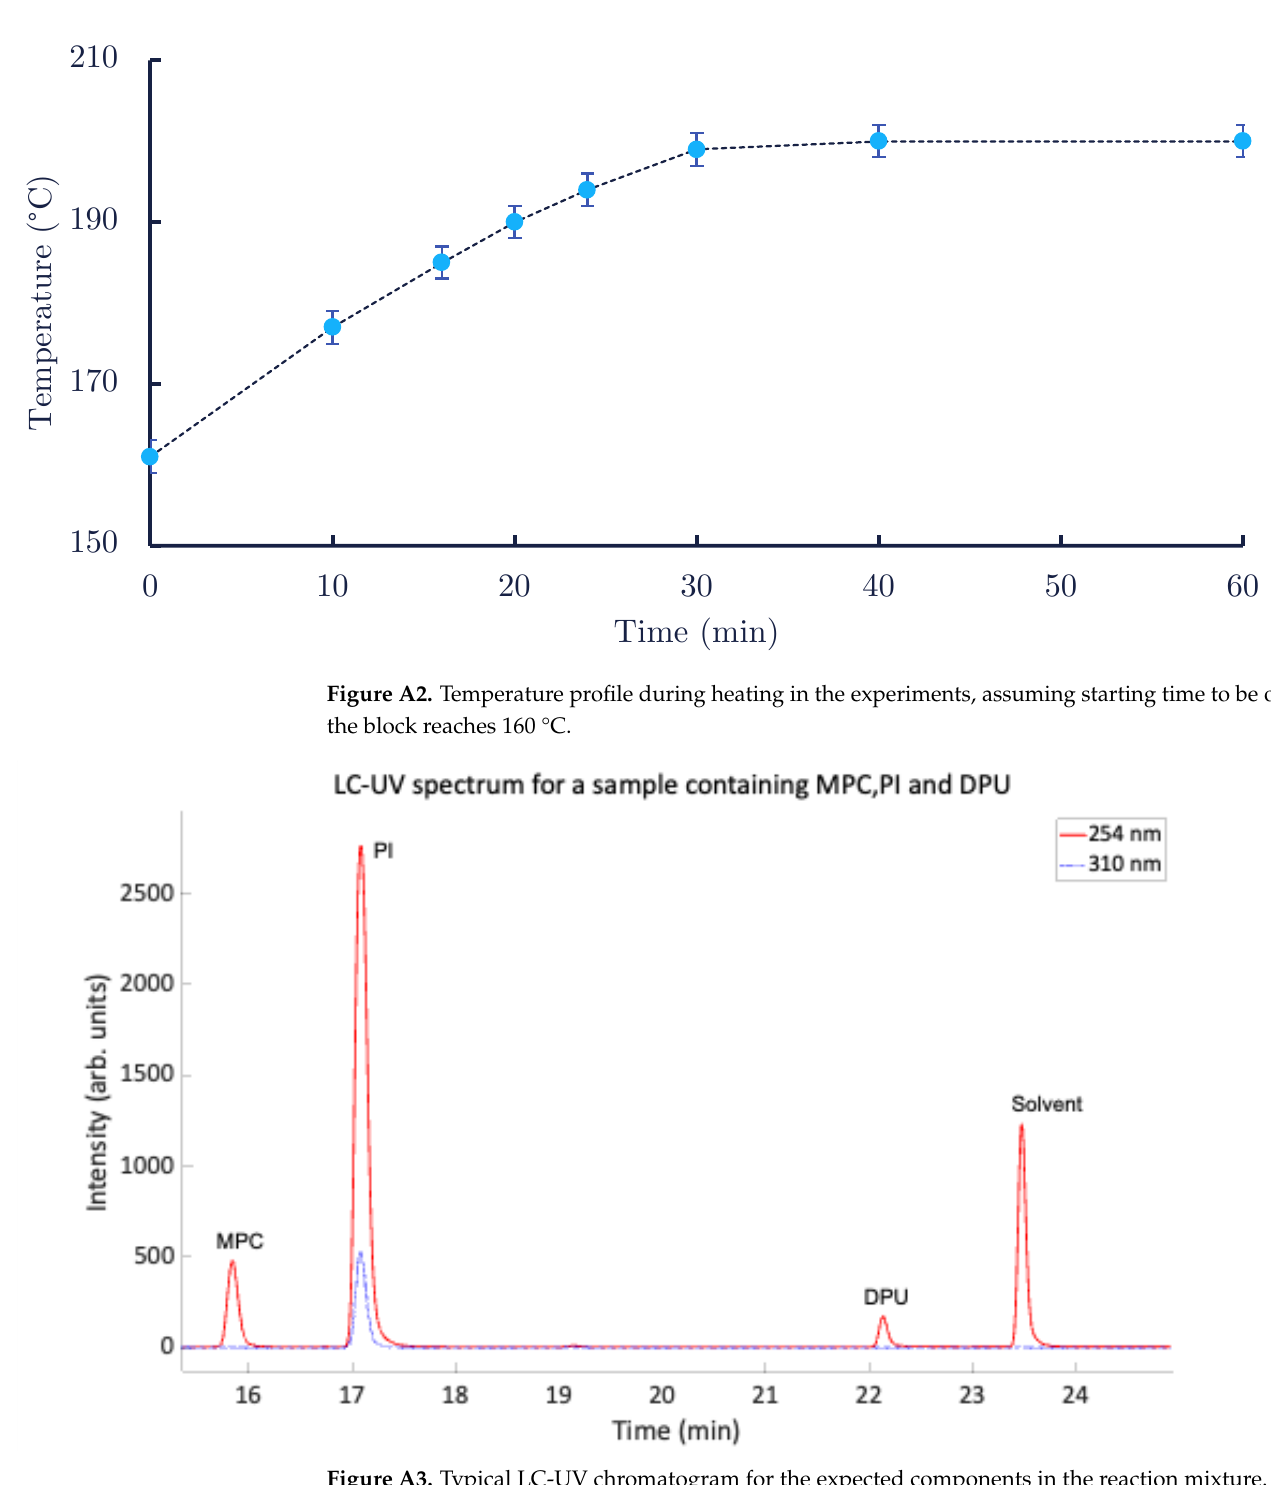
Figure A3. Typical LC-UV chromatogram for the expected components in the reaction